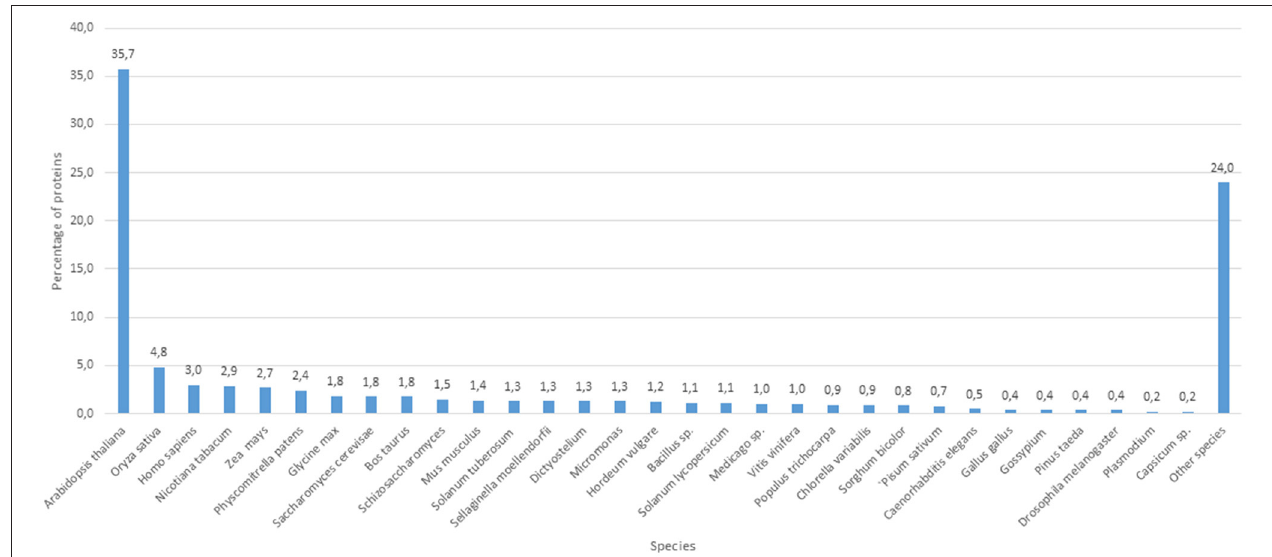
FIGURE 3 | Number of protein clusters obtained from the apogamous gametophytes of Dryopteris affinis and its sexual relative D. oreades , with the best hits to species belonging to the phylogenetic groups specified.